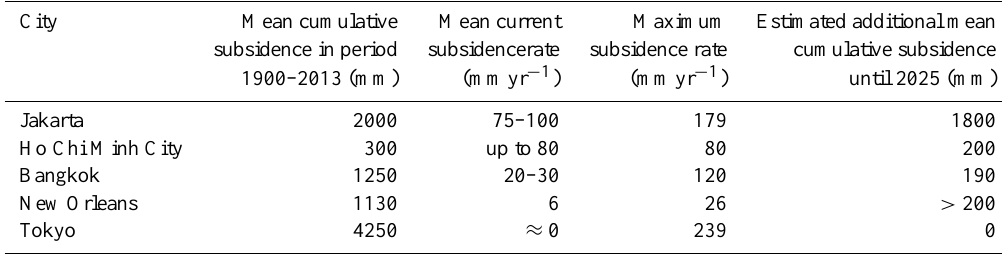
Table 1. Subsidence in coastal cities. Estimated additional mean cumulative subsidence until 2025 (mm) are linear interpolations of the current rates, notwithstanding any policy changes. Sources: Bangkok: MoNRE-DGR (2012), Aobpaet et al. (2013); Ho Chi Min City: van Trung and Minh Dinh (2009); Jakarta: Bakr (2011); Manila: Eco et al. (2011); West Netherlands: van de Ven (1993); Tokyo: Kaneko and Toyota